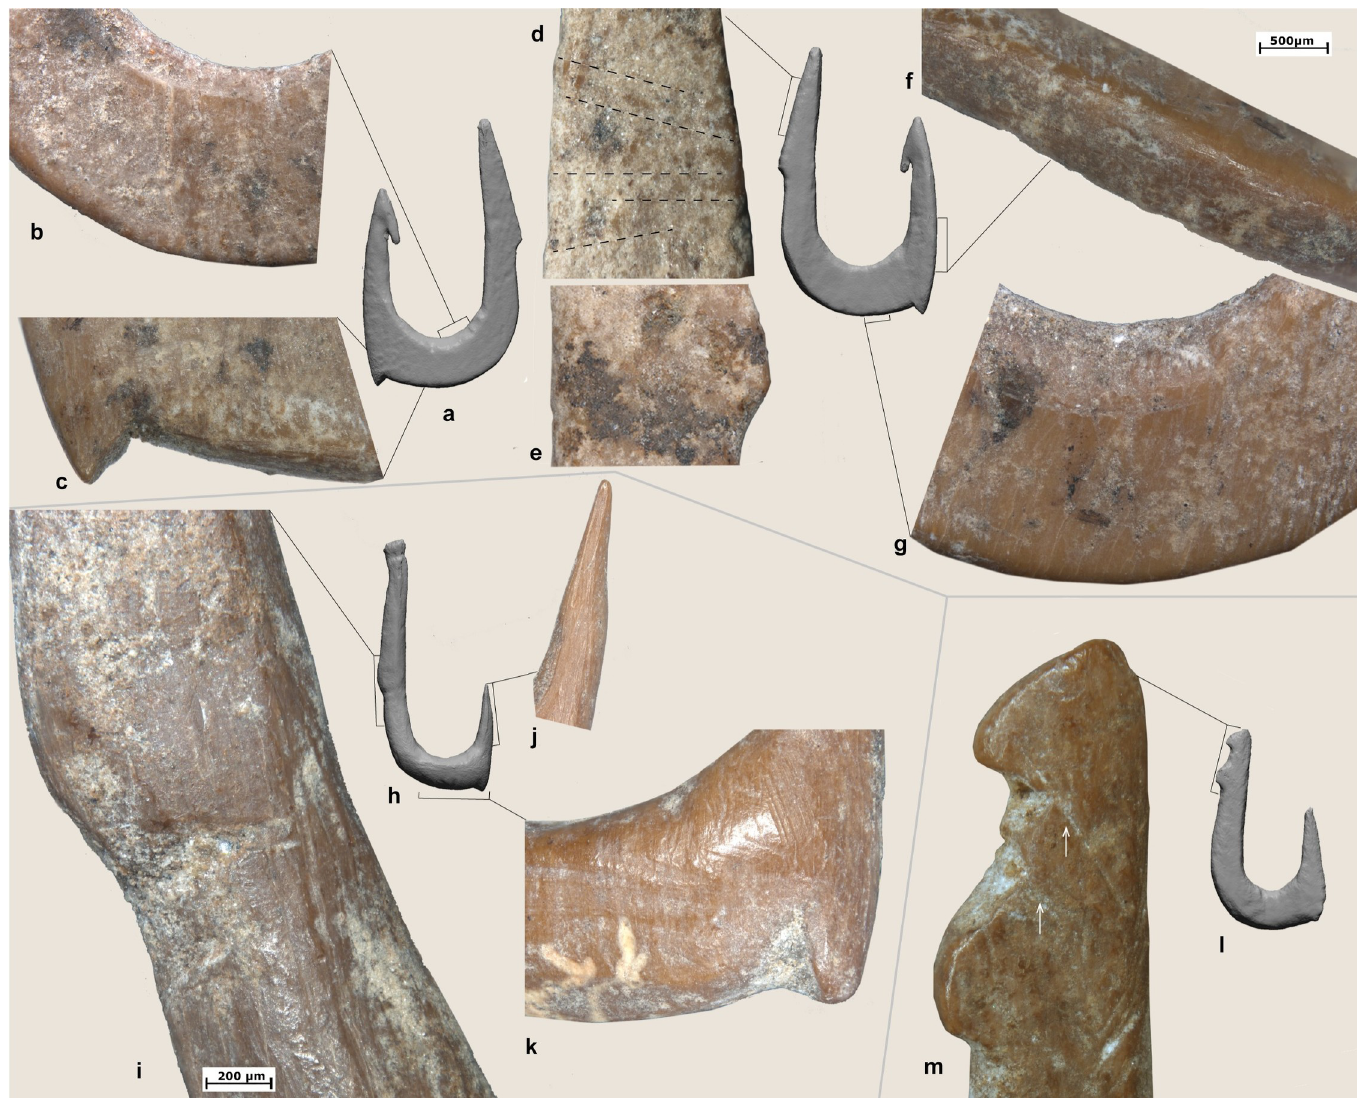
Fig 7. Technological traces and functional modifications on archaeological hooks (a) hook #1, h) hook #2, l) hook #3. b) Detail of the marks left during the preparation of the bend through drilling; c) detail of the barb and transversal grooving associated with its production; d) surface alteration associated with the decomposition of organic residues, still preserved on the other side of the hook; e) dashed lines indicate changes of color according to the disposition of the organic residues; f) scraping traces associated with the production of the shaft; g) perforation marks; i) j) k) transversal grooving applied to produce the barb; m) detail of the top of the shank. The arrows indicate technological mistakes produced by a lithic tool for creating a double knob for line